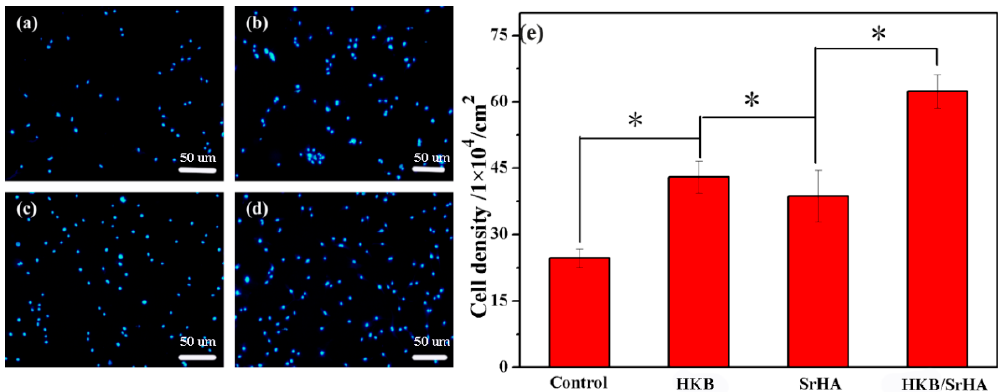
Figure 4. Fluorescence staining of preosteoblasts attachment observations: ( a ) Control, ( b ) HKB, ( c ) SrHA, ( d ) HKB/SrHA, ( e ) cell density of adhering cells cultured with different samples. * p < 0.05.